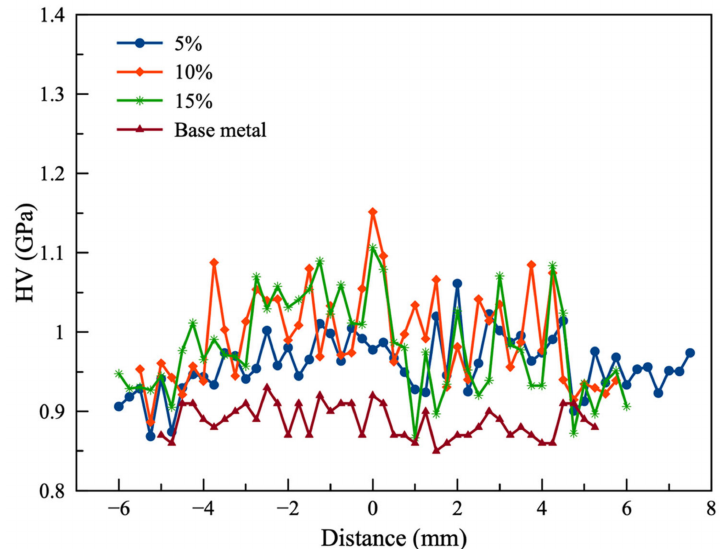
Figure 10. Microhardness profiles of Al-Mg-Sc alloy with Mo addition after four passes.